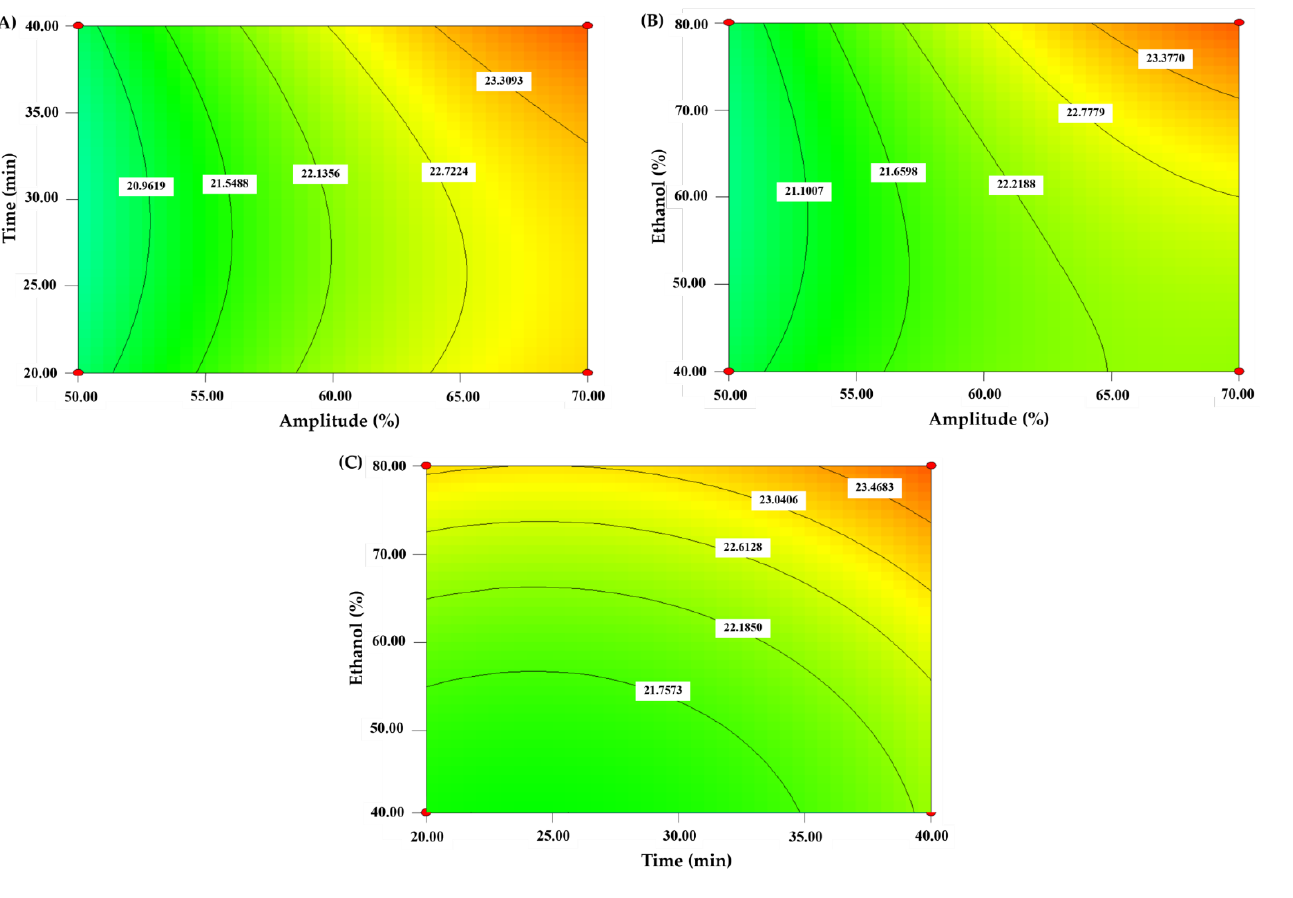
Figure 1. The contour plots of yield from CLE extraction as influenced by the chosen independent factors. ( A ) time and amplitude; ( B ) ethanol and amplitude; ( C ) ethanol and time.